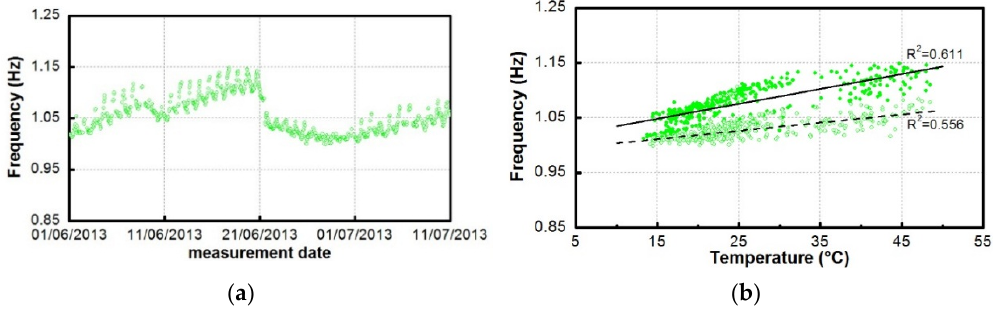
( a ) ( b ) Figure 13. Mode T 1 : ( a ) variation of the natural frequency between 01/06/2013 and 10/07/2013; and ( b ) change in the frequency ‐ temperature correlation induced by the seismic event of 21/06/2013.